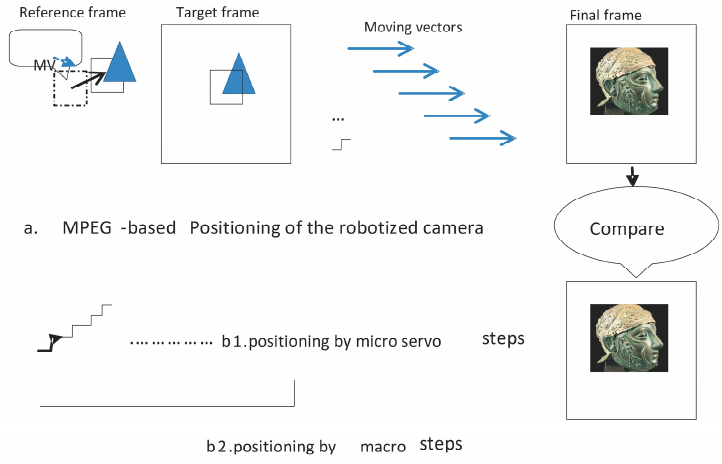
Figure 5. Example of testing of the robotized camera by different positing algorithm.